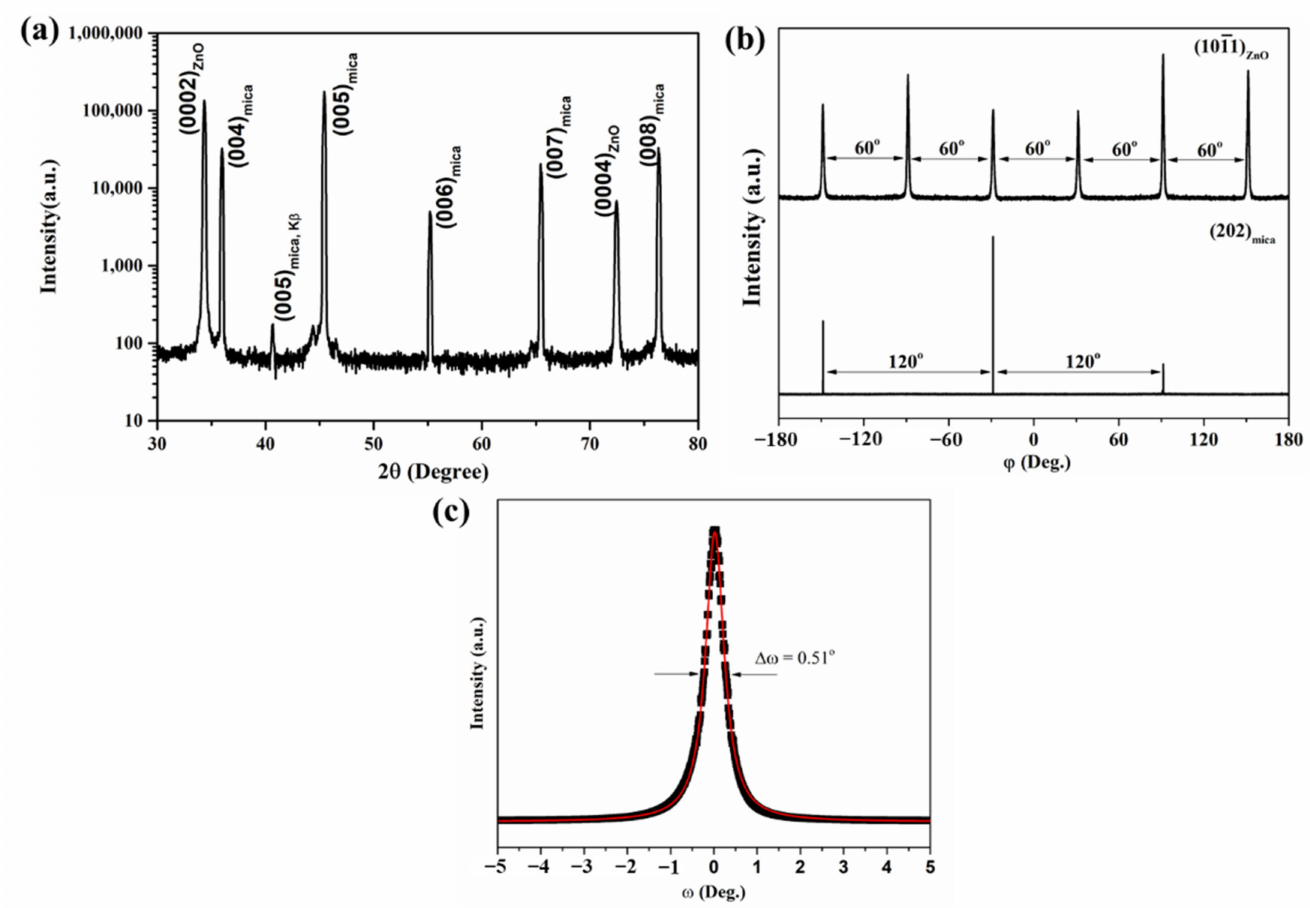
Figure 4. ( a ) XRD θ -2 θ profile, ( b ) XRD ϕ -scan of the ZnO {1011} and mica {202} reflections, and ( c ) Rocking curve profile of the ZnO (0002) reflection for the continuous ZnO film hydrothermally grown on 600 ◦ C annealed mica substrate from a solution containing 0.5 mM sodium